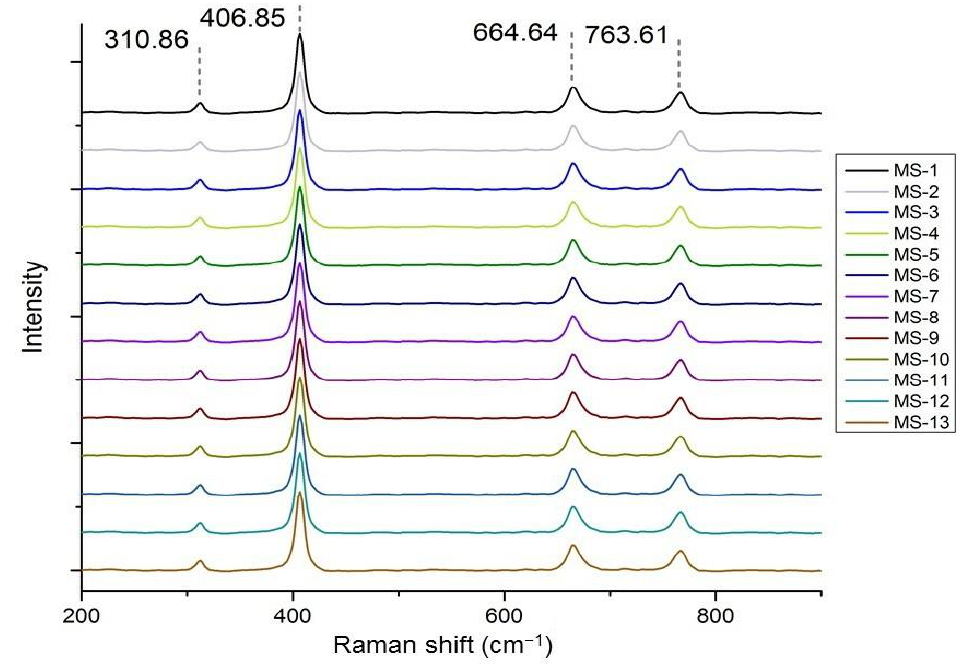
Figure 8. Raman Spectroscopy of ‘ Jedi ’ spinel from Man Sin .